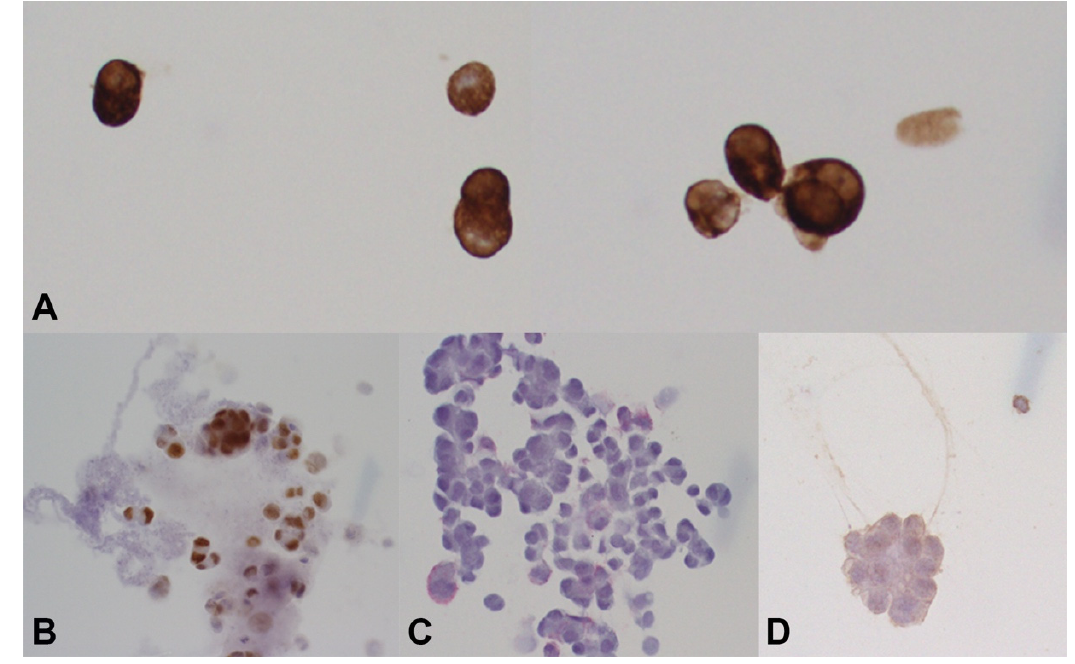
Figure 3. Immunohistochemical studies. Neoplastic cells depicting positive cytoplasmic staining for AE1/AE3 stain ( A ) and nuclear staining with PAX-8 ( B ). Negative expression for SOX10 ( C ) and S100 protein ( D ) was noted in tumor cells. Original magnification × 400 ( A ) and × 200 ( B – D ). At the follow-up, one week after vitrectomy, the vision in the right eye had improved to 20/60. On clinical examination, the anterior chamber and vitreous each had 1+ cell, and an inferior vitreous base opacity was noted. OCT of the right macula showed a sawtooth like aggregation of cells on the pre-retinal surface with an intact foveal depression (Figure 1C). Choroidal thickness appeared normal and symmetric between the two eyes. The IVFA of the right eye was repeated to better evaluate the fundus and demonstrated diffuse patchy hyperfluorescence with hypofluorescence adjacent to the retinal arteries, optic nerve staining, and mild angiographic macular edema in the late phase (Figure 1D). There continued to be areas of venous hyperfluorescence seen best along the superior-temporal arcade suggestive of mild retinal vasculitis. The patient developed vitreous hemorrhage in the right eye, one month postopera- tively causing light perception vision and precluding an accurate evaluation of the fundus and detection of possible therapy-related changes. Three months after the vitrectomy, the patient presented clinical findings consistent with neovascular glaucoma. Bevacizumab intravitreal injection was recommended. The patient’s condition deteriorated, and he passed away six months later. 3. Discussion RCC continues to represent an increasing proportion of the cancer landscape. This steady rise, continuing over the past 20 years, reflects an increase in the radiographic iden- tification of incidental masses. However, RCC mortality has not declined in that time frame, implying that the increase in diagnoses is not solely due to early detection. RCC has risen to become the 7th most common cancer in men and the 8th most common cancer in women in the United States [11]. About 17% of patients with RCC have metastatic dis- ease on initial presentation, with lungs being the most common metastatic site [11]. Uveal metastases from the kidney have been found rarely. Shields et al., [3] in their survey of 520 eyes with uveal metastases, report that 2% of the cases came from the kidney. The biology of RCC is characterized by demonstration of VHL-associated molecular pathways. Patients with germline mutations in the von Hippel-Lindau (VHL) tumor sup-